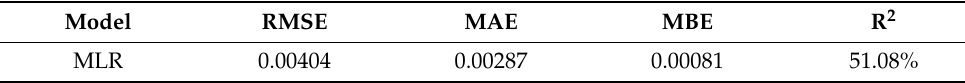
Table 5. Statistical prediction performance of the MLR model.